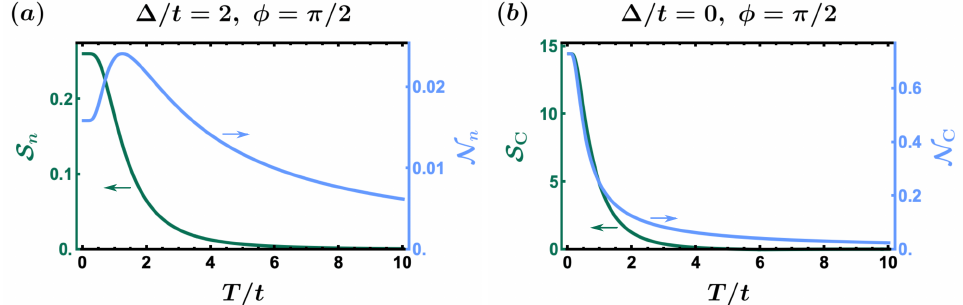
Figure 8: Signal (20) and noise (21) for the 2-MZM measurement of the aver- 〉 (a) and differential QD capacitance C age QD charge 〈 n QD tion of temperature T for φ = π/ 2 and different values of ∆ / t . Here we set | t | = t , | t | = 1.5 t , t = (cid:34) / 5 = 0.02 meV, C 1 2 C (cid:112) α = ing noise of strength C